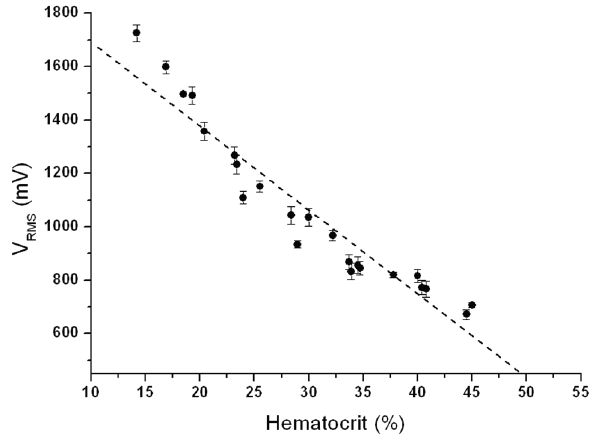
Figure 3. Measured output dc voltage (V RMS (mV)) mean value ( n = 5) as a function of blood samples hematocrit (Hematocrit